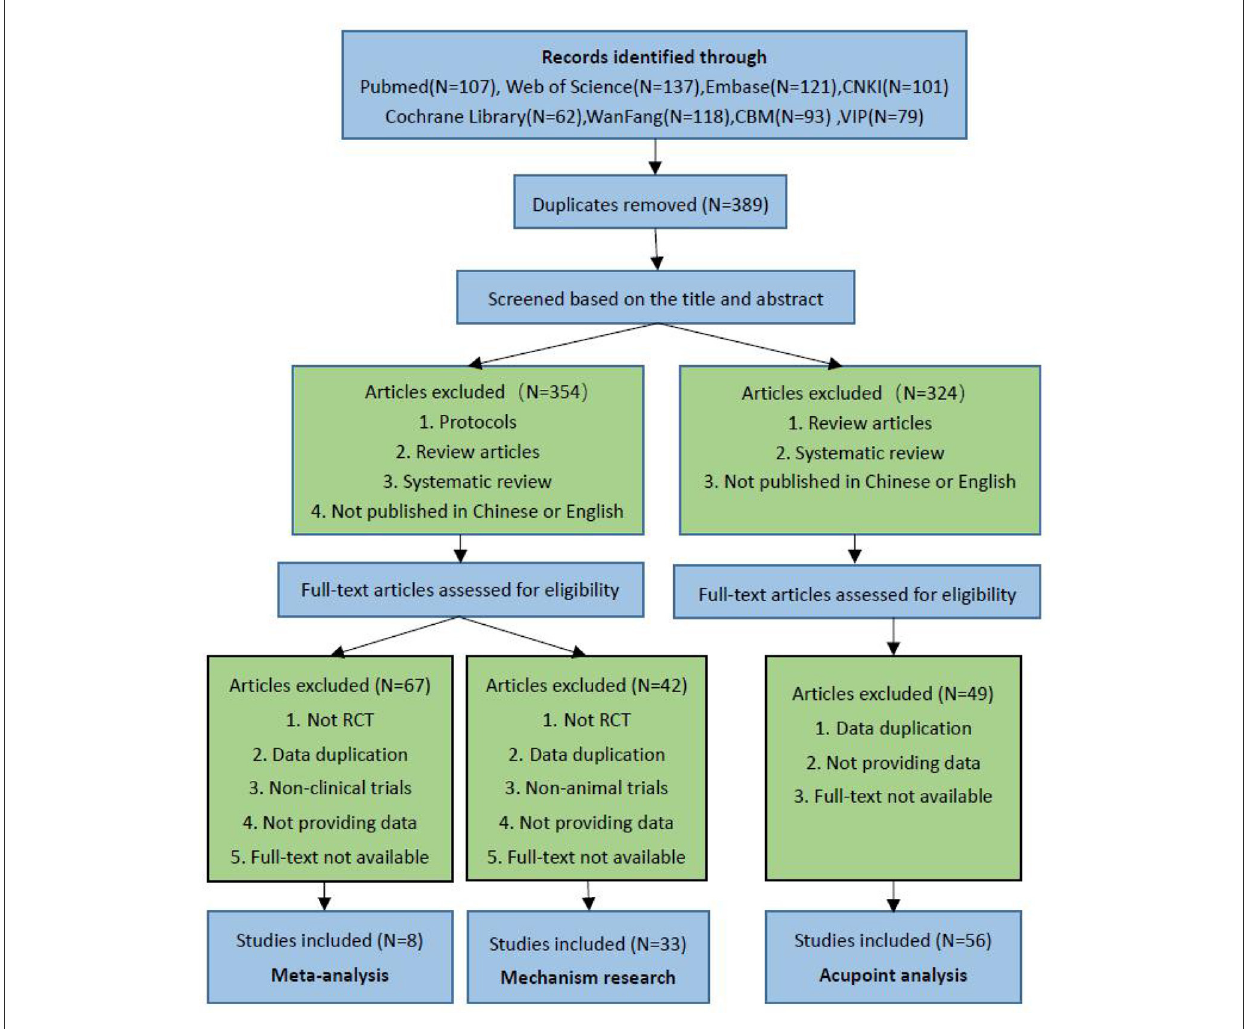
FIGURE1 A flow diagram of the literature screening and selection